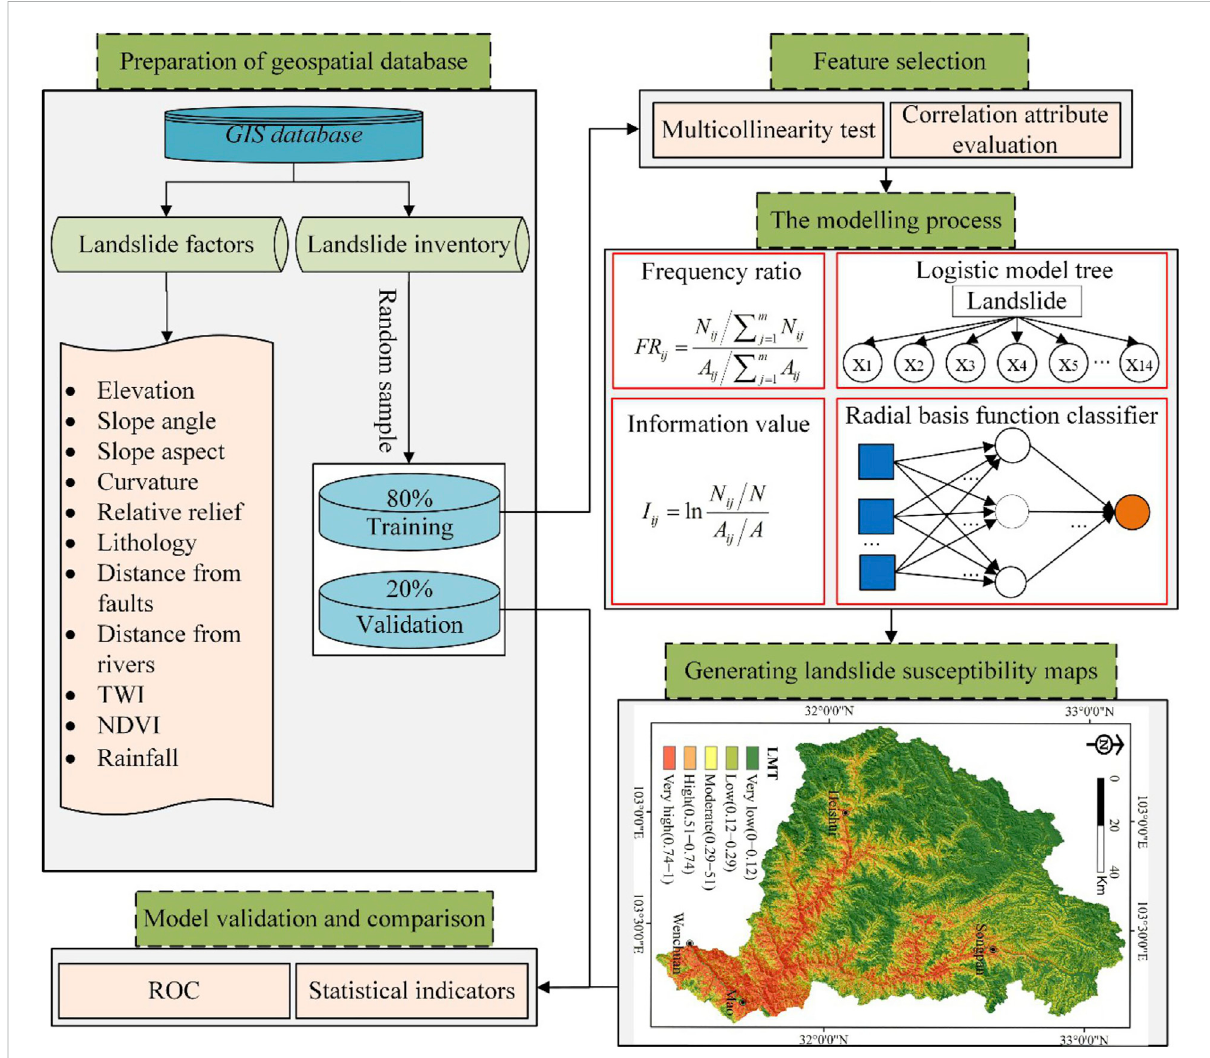
FIGURE 4 Study fl owchart for landslide susceptibility for the upper reaches of the Minjiang